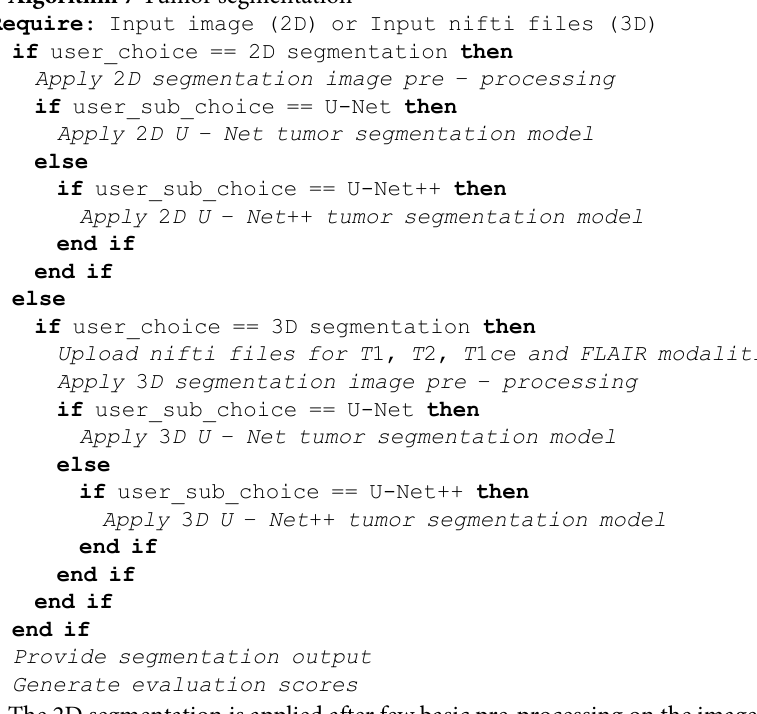
Algorithm 7 Tumor